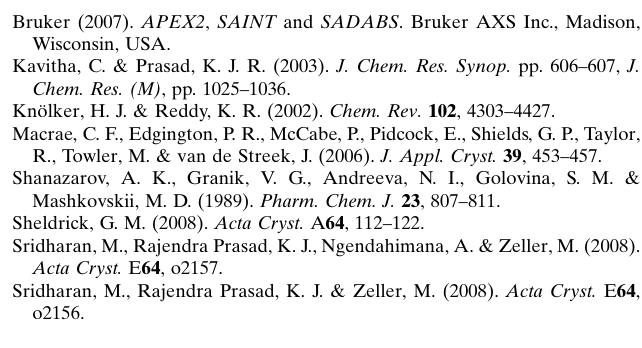
Experimental Crystal data